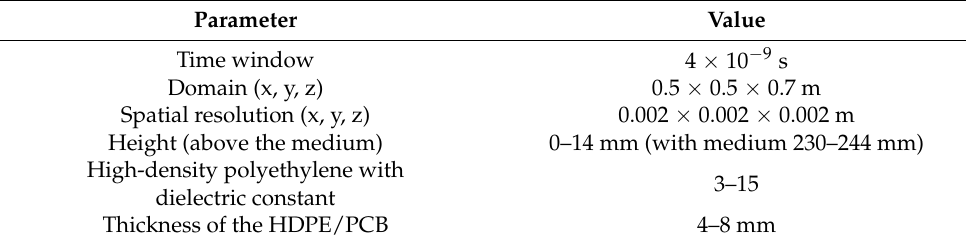
Table 1. Parameter variable considered for antenna model